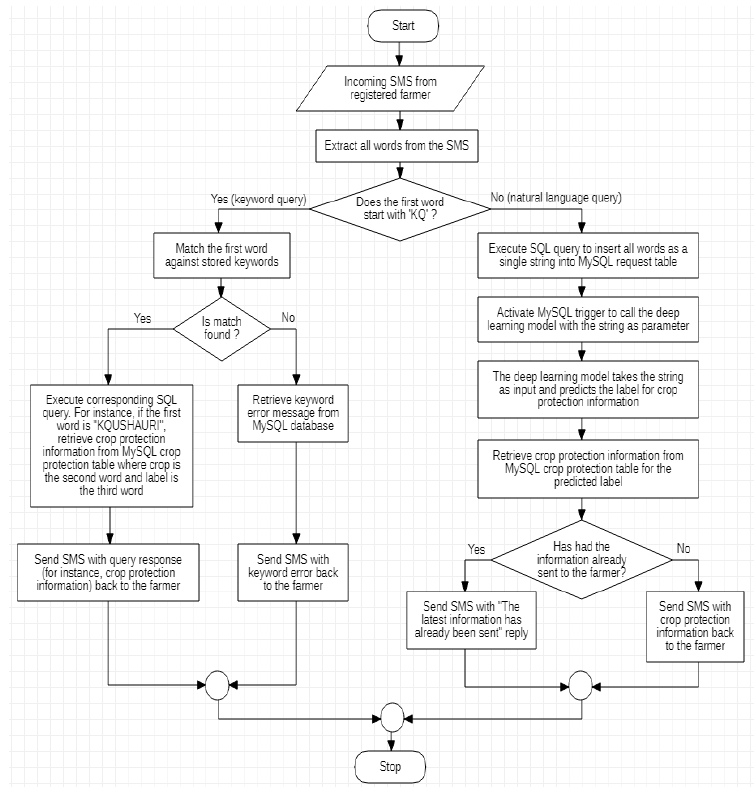
Figure 5. Algorithm for processing SMS queries.